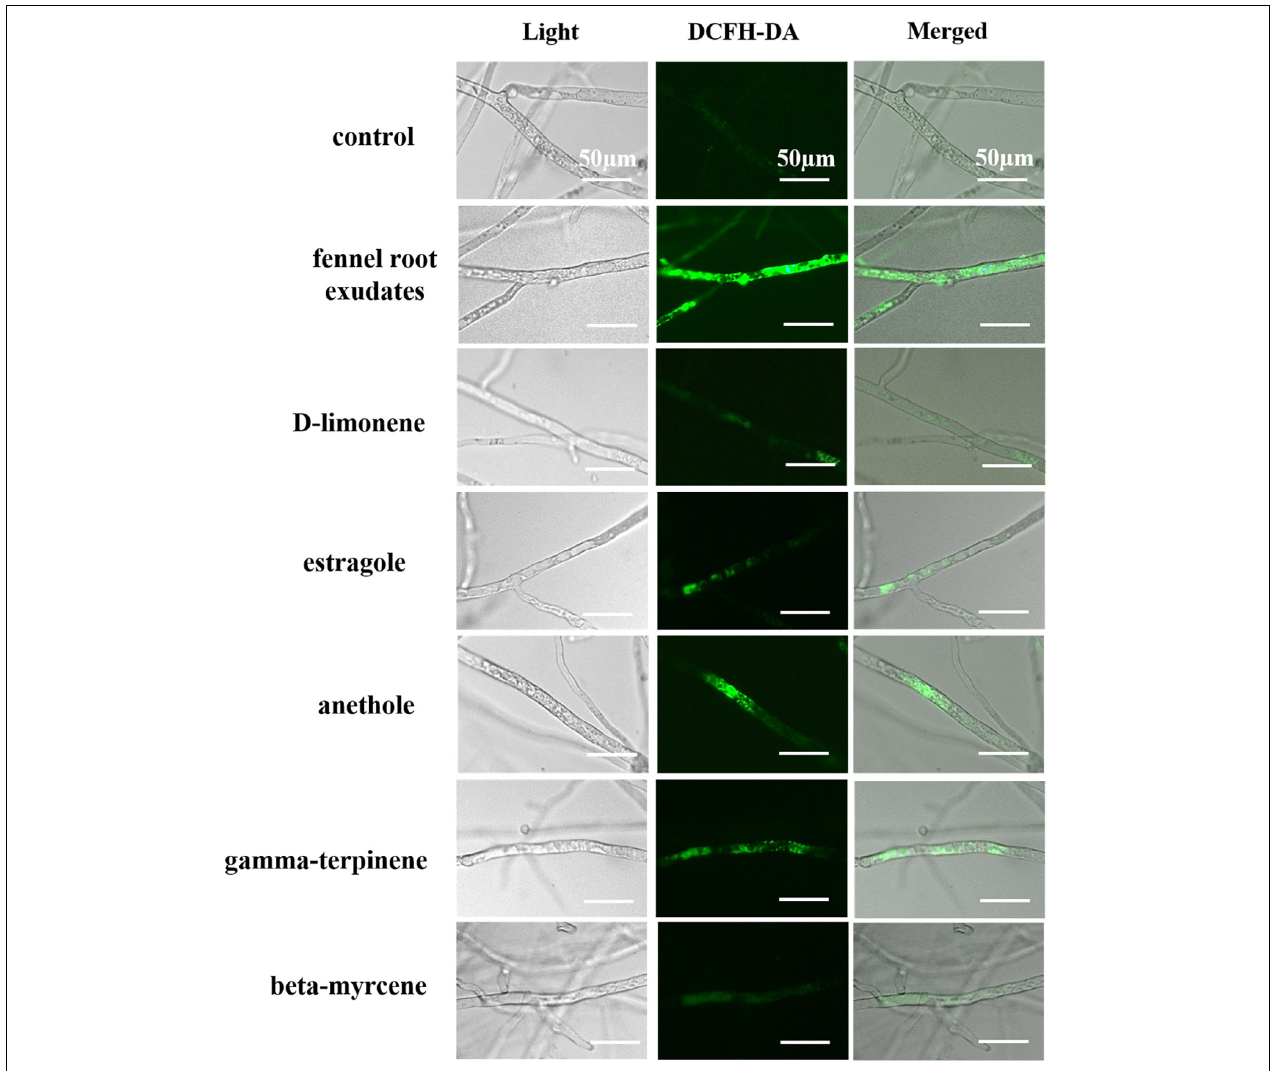
FIGURE 6 | Fennel root exudates and terpene compounds induced ROS accumulation in P. capsici hyphae. Bar = 50 µ